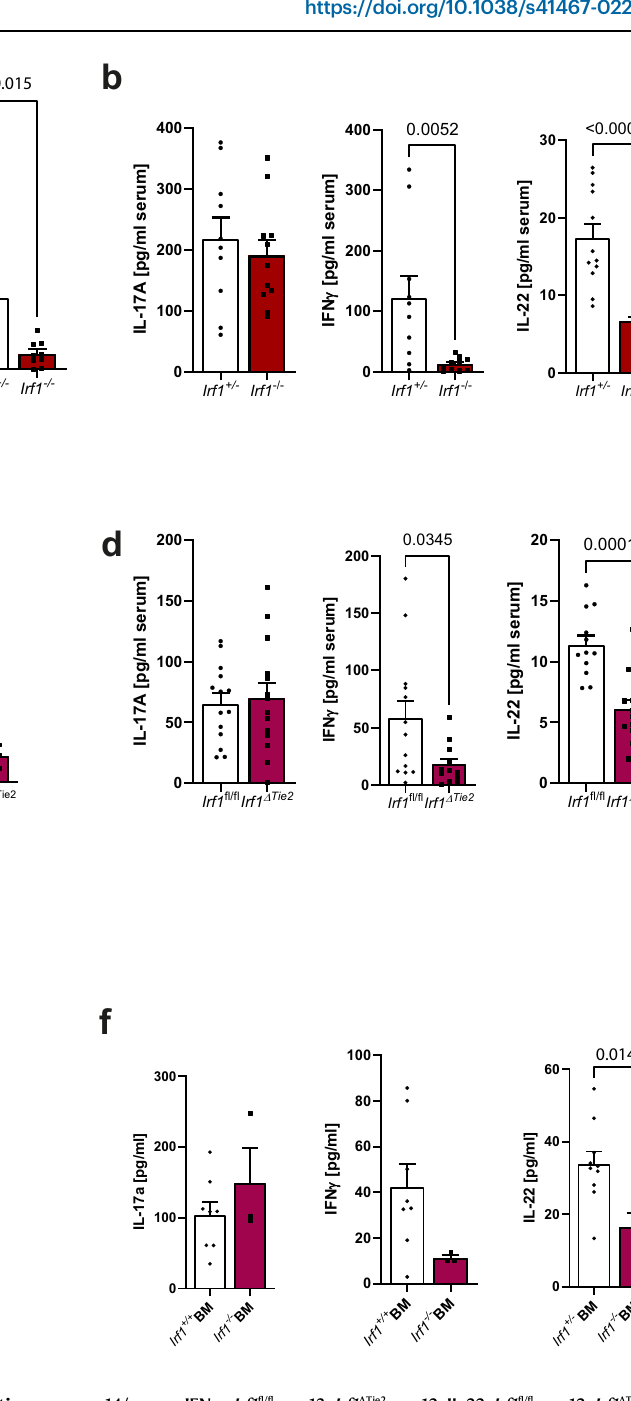
Fig. 4 | Irf1 de fi ciency impairs IL-22 and IFN- γ secretion during C. rodentium infection.a , b Irf1 – / – andcontrolmicewereinfectedwith C.rodentium . a TotalRNA of distal colonic tissue (8 dpi) was analyzed by speci fi c qRT-PCR. ( Il17 , Ifng : Irf1 +/ –